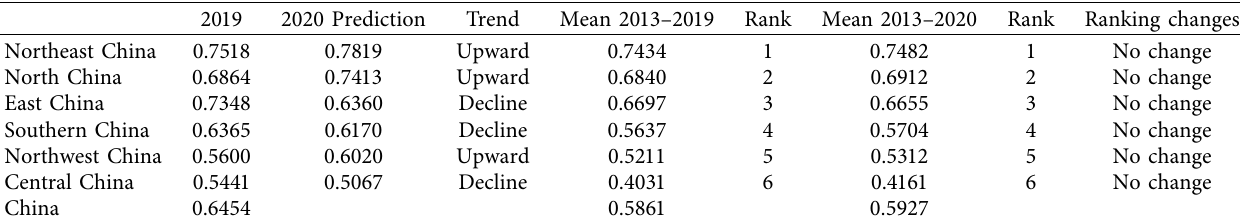
Table 5: Predicted value of wind power utilization efficiency in six regions